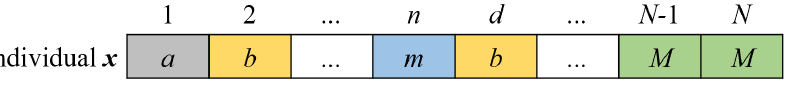
Figure 3. The simplified encoding.